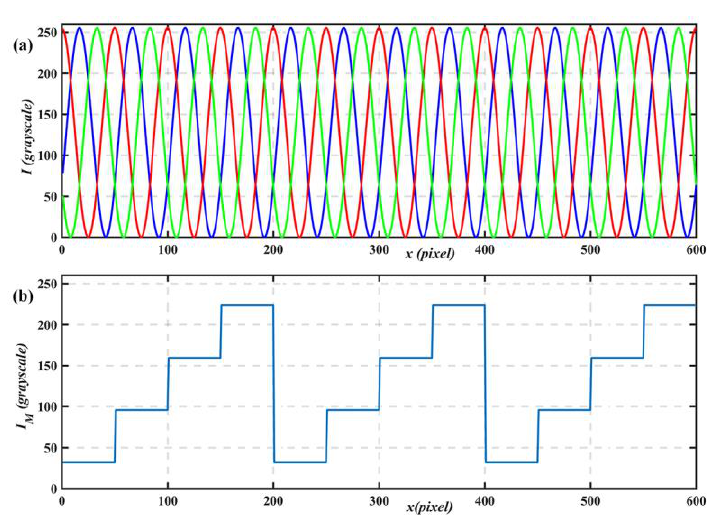
Figure 3. Same rows as in Figure 2. ( a ) Phase-shift patterns; ( b ) coded pattern.